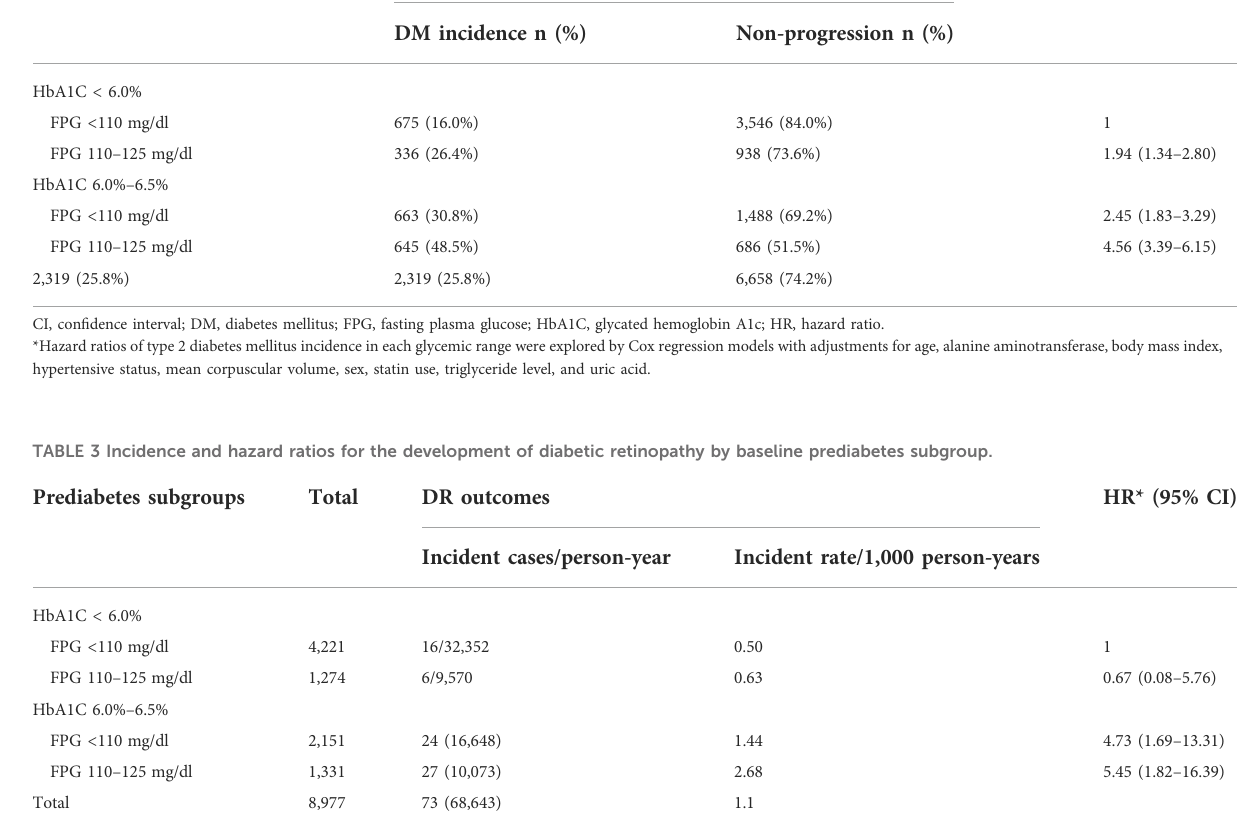
TABLE 2 Five-year incidence and hazard ratios for the development of diabetes by baseline prediabetes subgroup. Prediabetes subgroups